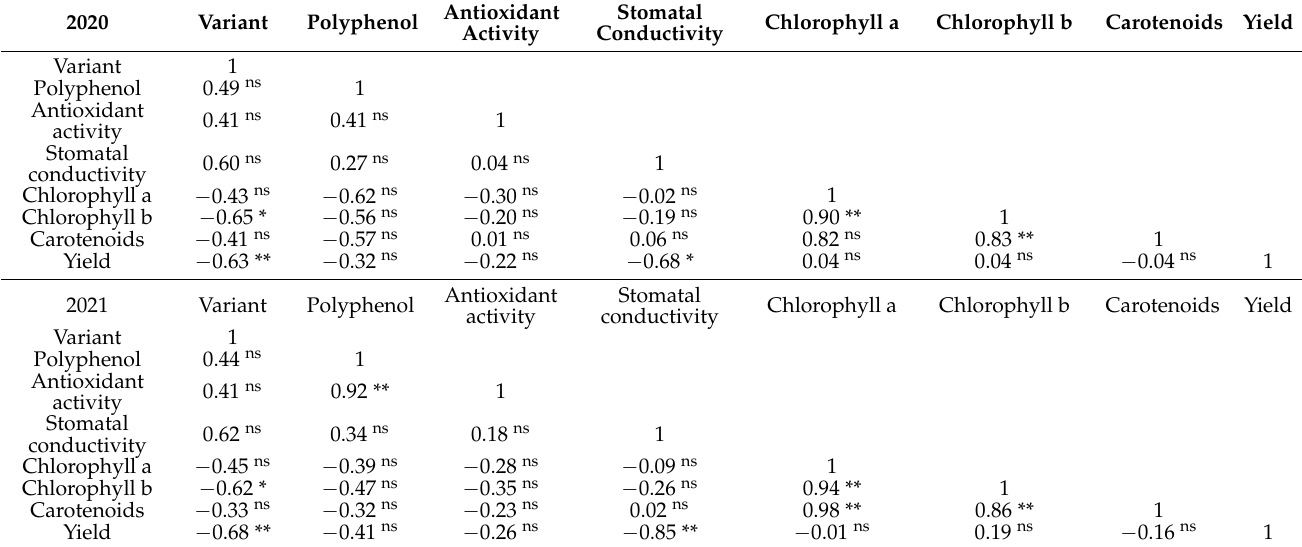
Table 4. Pearson correlation coefficients for studied